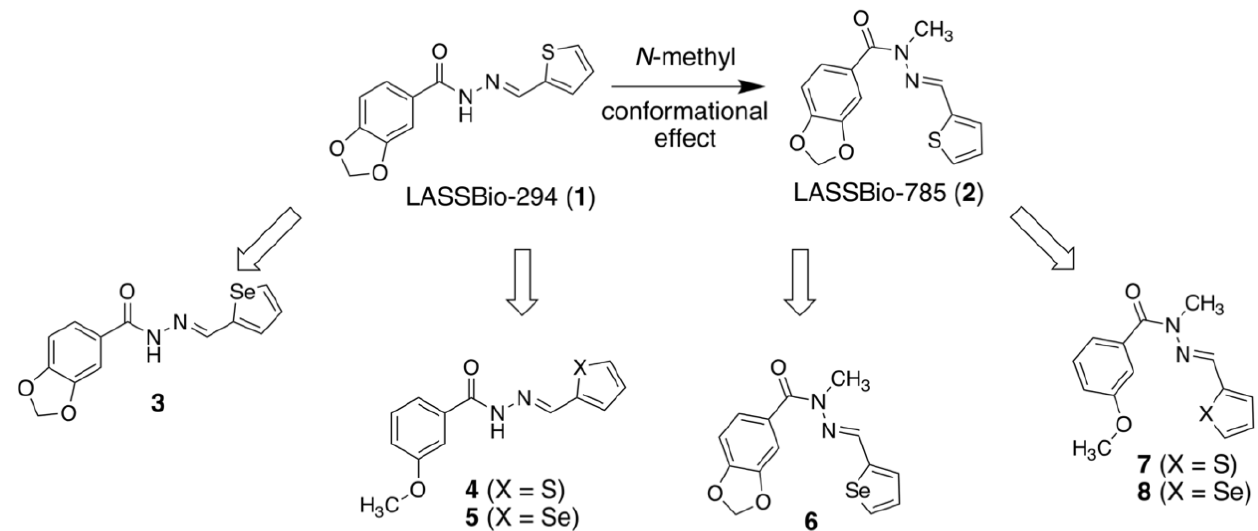
Figure 3. Molecular design of novel N -acylhydrazone derivatives. Series of isosteric NAH analogues to the previously described LASSBio-294 ( 1 ) and LASSBio-785 ( 2 ).